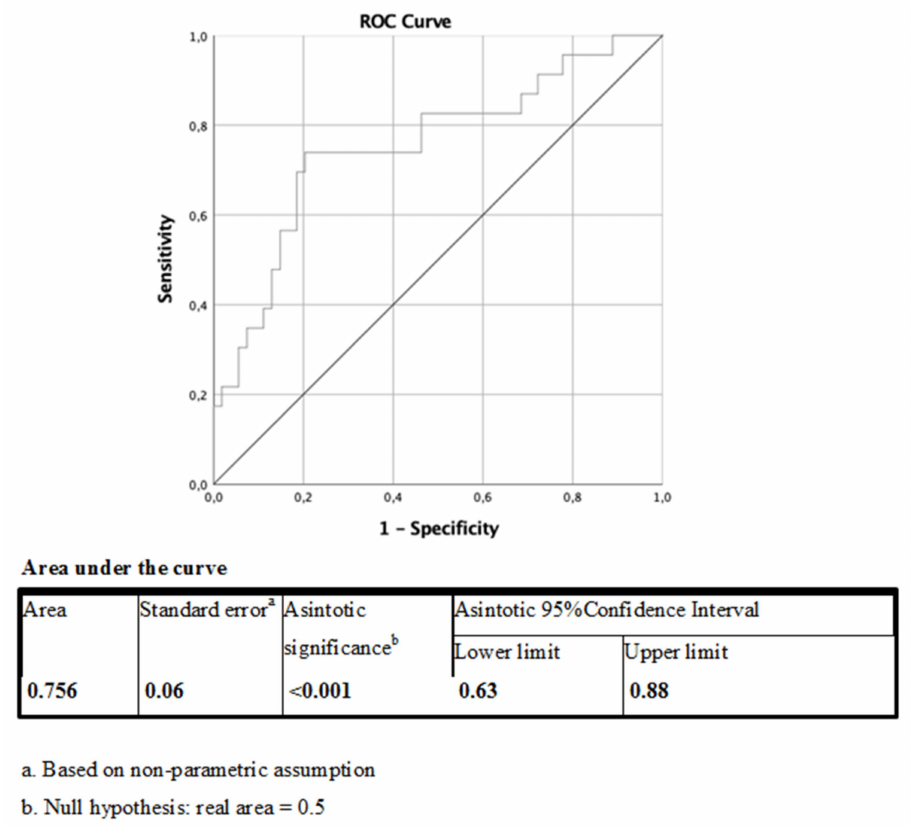
Figure 2. VAT ANGPTL4 receiver operating characteristic (ROC) curve for presence of abnormal glucose metabolism (AGM) corrected for age and